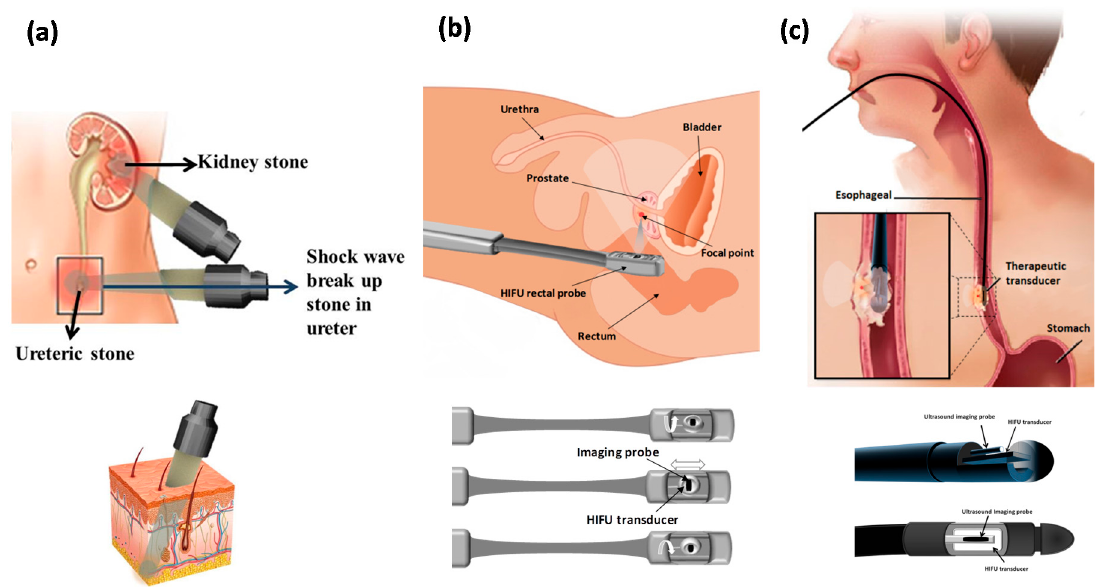
Figure 4. Schematic of high-intensity focused ultrasound applications in ( a ) lithotripsy; with an extracorporeal ultrasound transducer ( b ) prostate cancer; with a typical transrectal ultrasound transducer for prostate cancer treatment with both therapy and imaging transducers incorporated into the head of the transducer probe ( c ) and esophageal cancer; the front and side view of the head of the interstitial transducer used for the treatment of esophageal tumors.